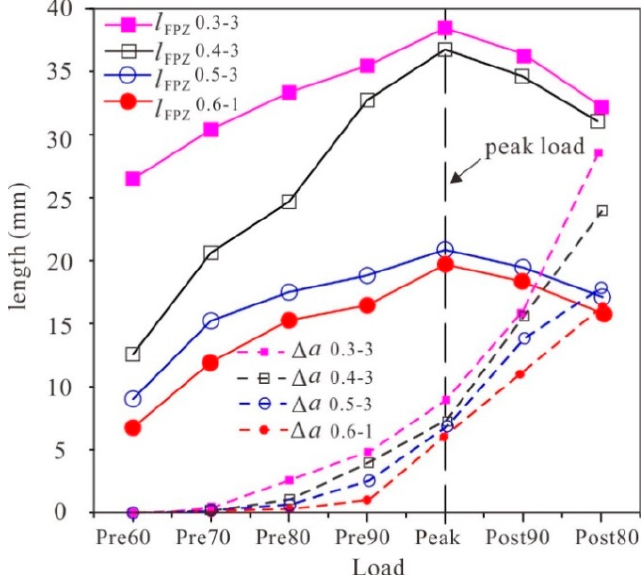
Figure 12. Evolution of the fracture process zone (FPZ) and the equivalent elastic crack.